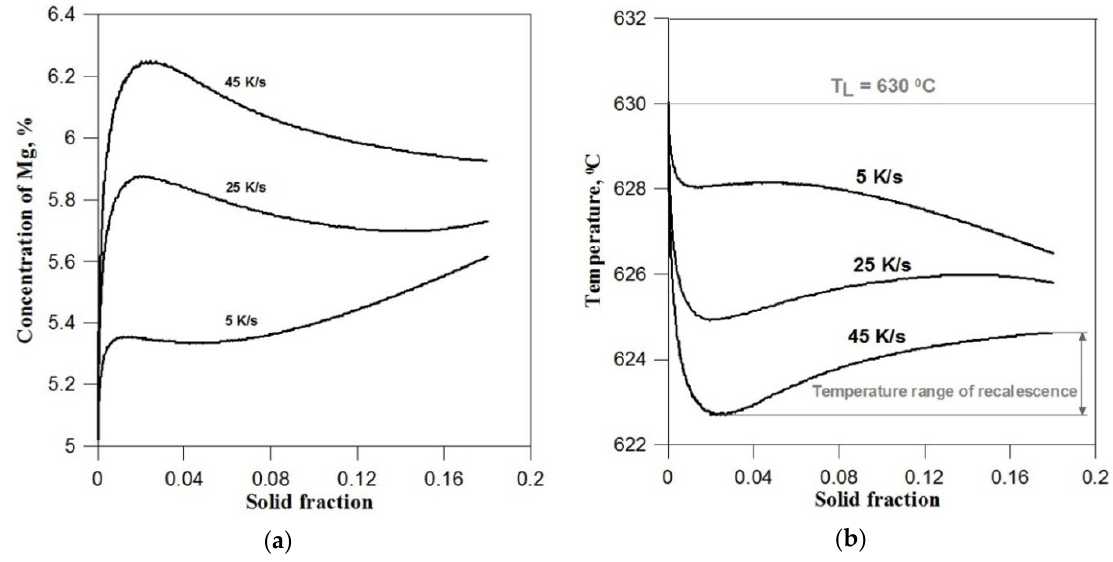
Figure 4. ( a ) changes in the concentration of magnesium at the solidification front depending on the share of the solid phase (dendrite size) and different cooling rates, ( b ) changes in the average temperature in the initial period of crystal growth.